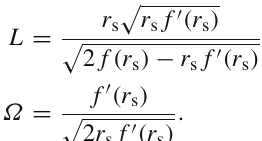
Fig. 4 Direct (black line) and secondary (red line) images of the thin accretiondisksurroundingtheSchwarzschild-MOGBHunderdifferent values of parameter α and inclination angles. From the center of each